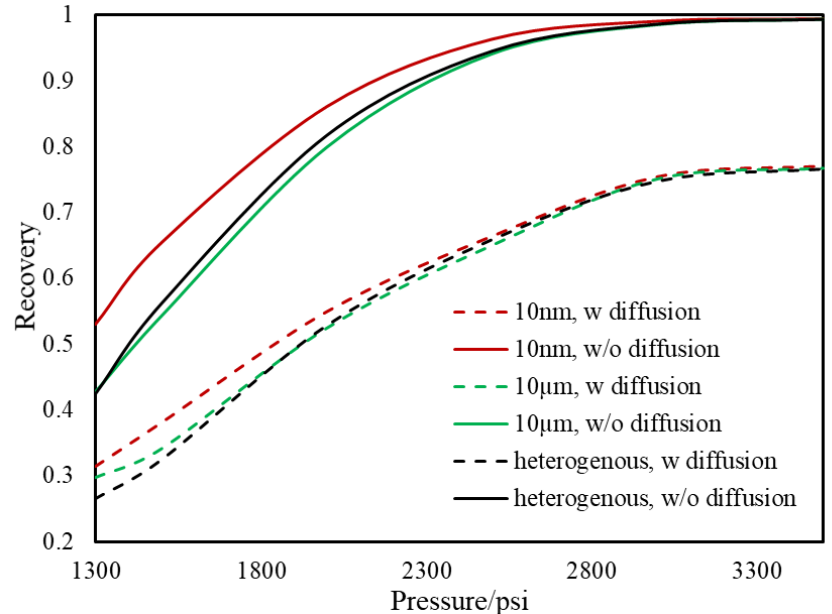
Figure 18. C 5 -C 6 Composition recovery as a function of pressure with and without diffusion for slim tube simulation, Bakken, 100 nd.